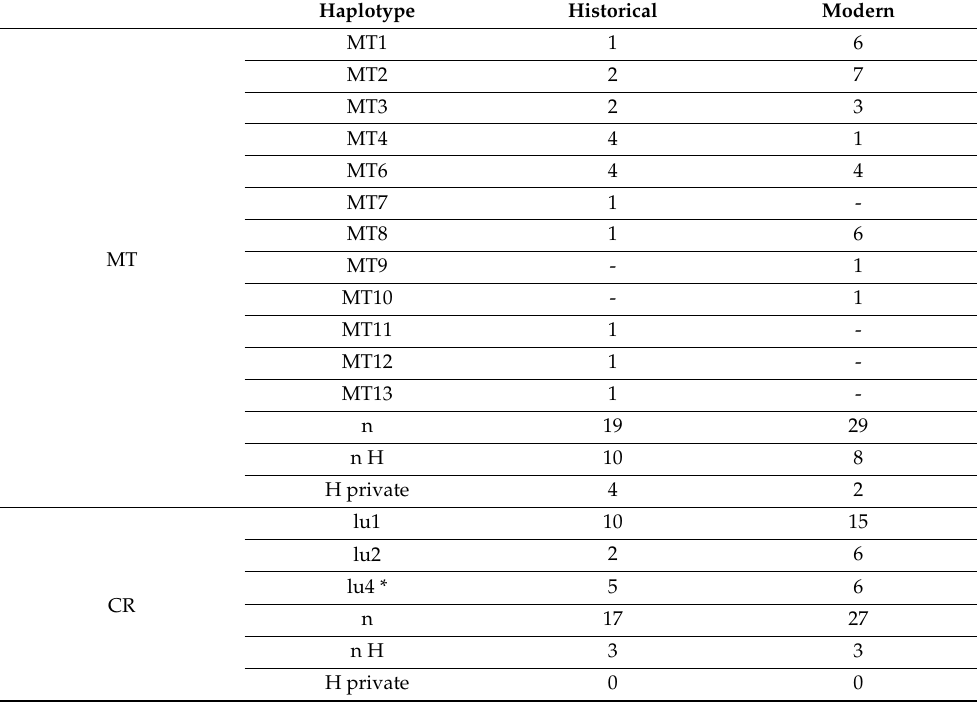
Table 3. Distribution of haplotypes in historical and modern Iberian wolves. Number of times each haplotype was identified in historical or modern Iberian wolves, total number of individuals sampled (n), the total number of haplotypes identified (n H), and unique haplotypes for each group (H private), using the entire mitogenome excluding the control region (MT) and only the 5 (cid:48) end of control region